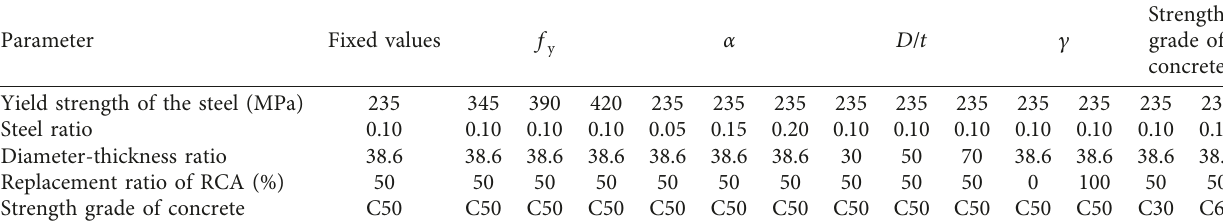
Table 5: Combinations of f